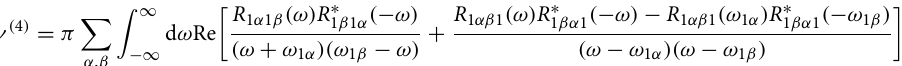
Figure 5. Temperature dependence of the phonon-assisted relaxation rate Ŵ dephasing rate for the coherence represented by is taken at the “sweet spot” F fourth-order contributions, as well as the total rate, as defined in panel ( a